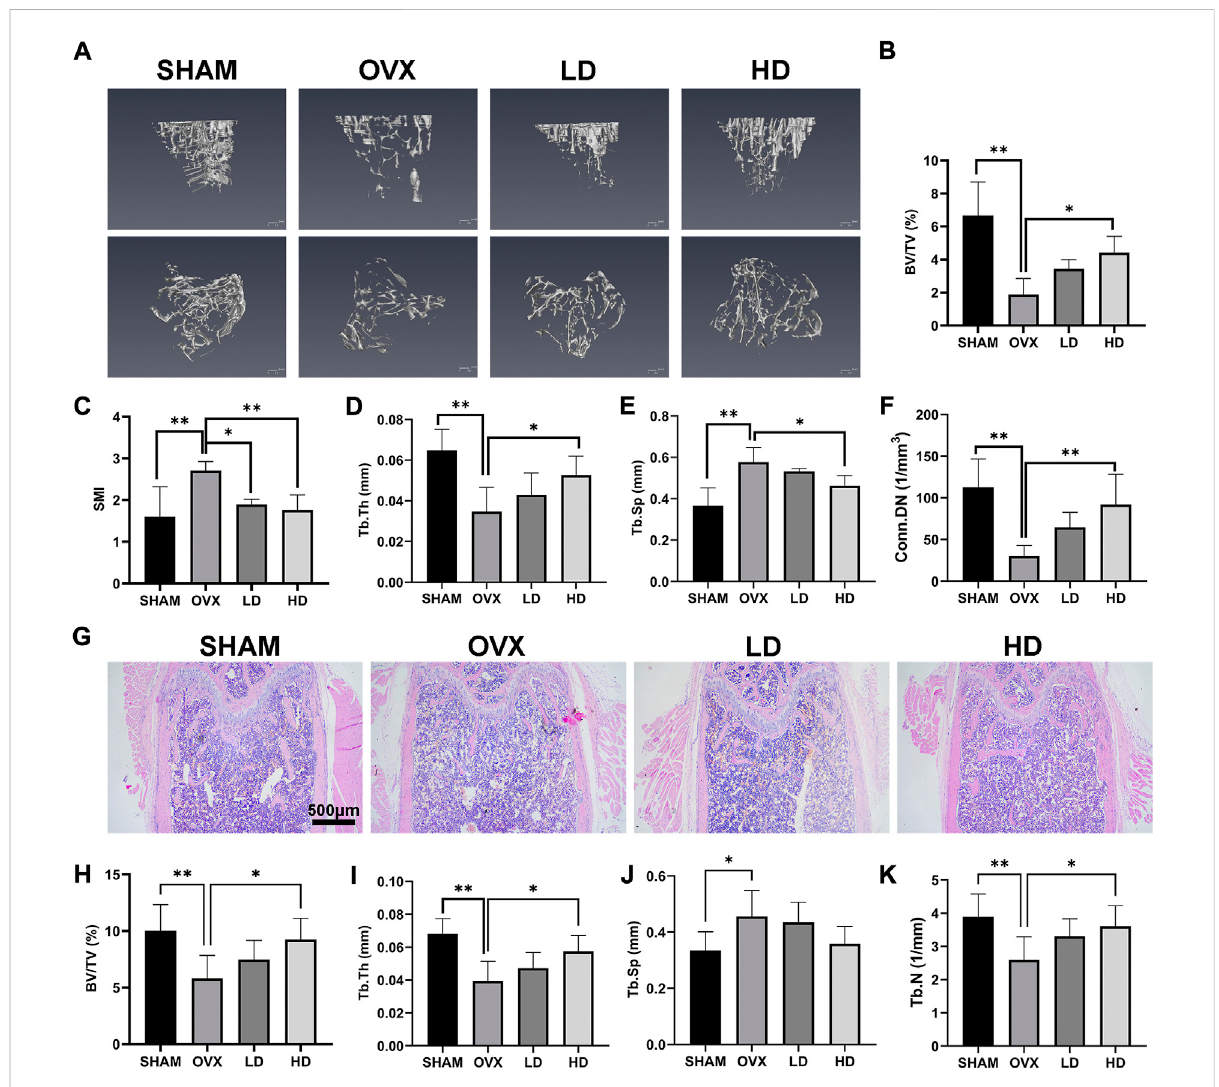
NCTD can alleviate OVX-induced osteoporosis in mice. (A) After the osteoporosis model was established after OVX surgery, the left tibia of the mice was taken for micro-CT scanning after intraperitoneal injection of PBS/NCTD. (B) BV/TV (%) were quanti fi ed after micro-CT scanning of the tibia. (C) SMIresults of micro-CT scanningof tibiainmice. (D) Tb.Th (mm)quanti fi cationof micro-CT scanning. (E) Quantitativehistogram ofmicro- CT scanning results Tb.Sp(mm). (F) Conn.DN (1/mm 3 ) quanti fi cation of micro-CT scanning. (G) After OVX surgery, the mice were established into osteoporosis model and then themice wereintraperitoneally injected with NCTD/PBS.The left femur of themice wastaken for paraf fi n section andH&Estaining. (H – K)